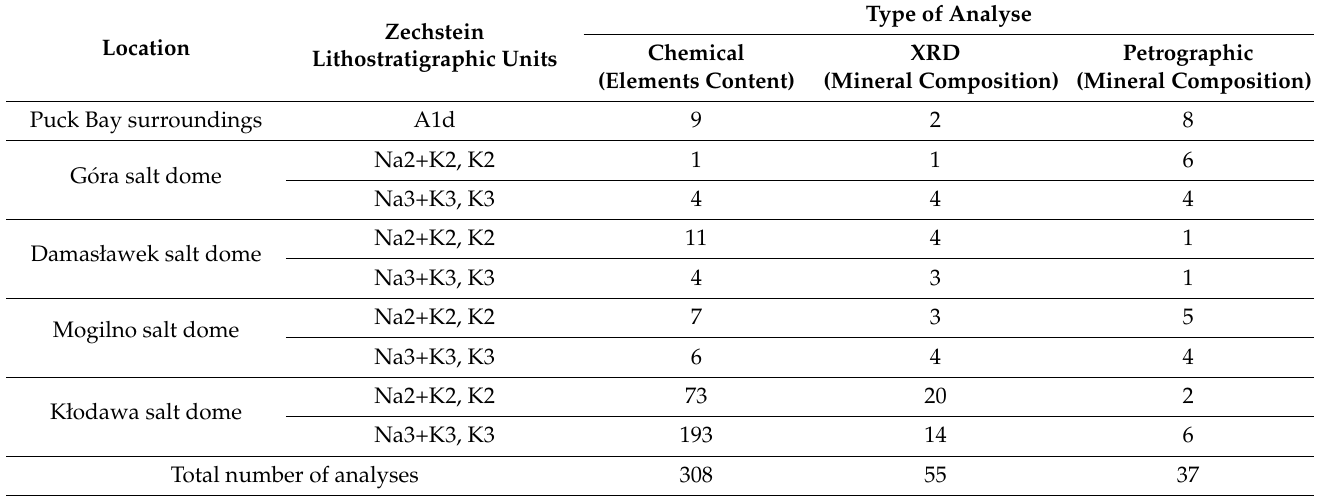
Table 3. Types, number, and location of analyses of sampled Zechstein potash-bearing deposits in